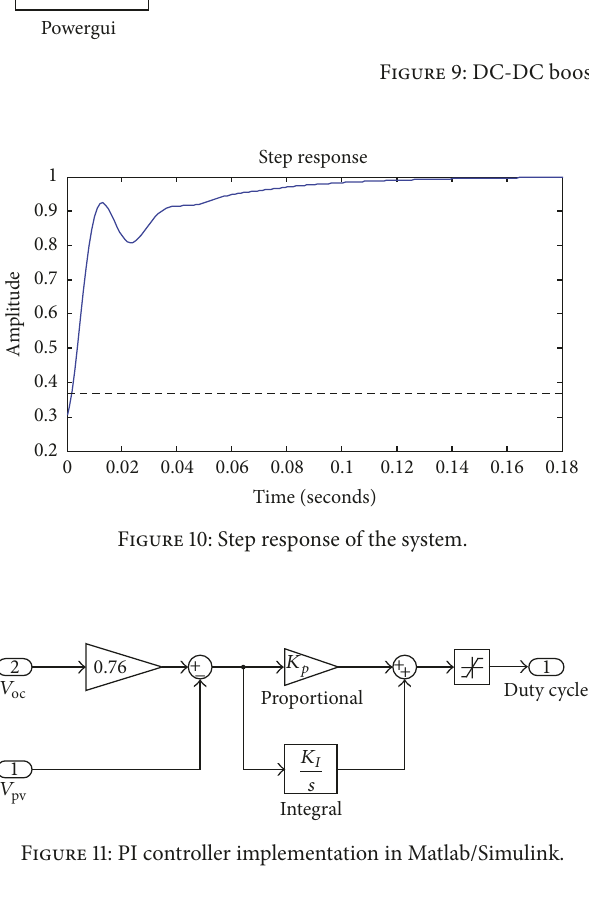
Factor 𝐾 in (16) is less than a unity, and it varies according to the solar irradiation and ambient temperature. The variation of factor 𝐾 is between 0.71 and 0.8, but the commonly used value for this factor is 0.76.